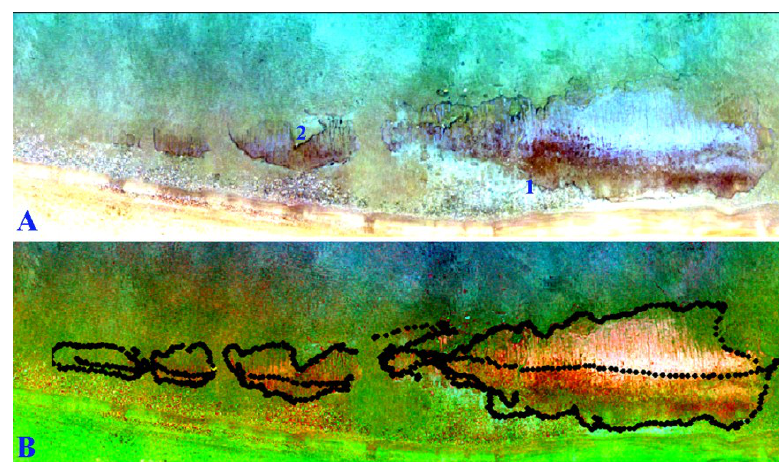
Figure 4. ( A ) Processed orthophoto of Figure 3A after enhancement in sharpness and contrast. The sampling positions are marked with numbers 1 and 2. ( B ) Result of the filtering application to the previous orthophoto. Black points represent the global navigation satellite system (GNSS) measurements.